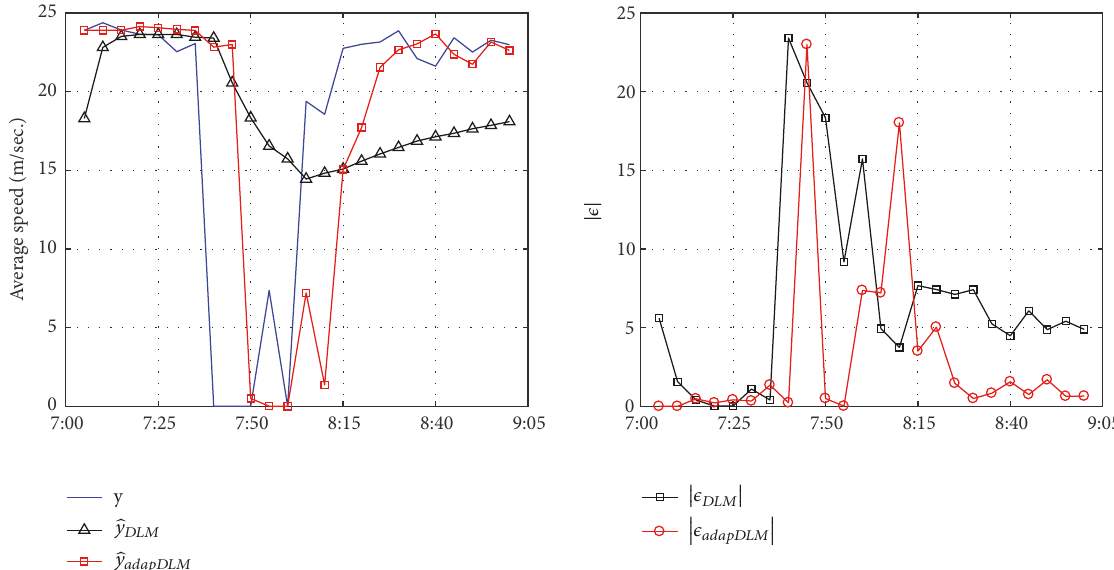
Figure 6: Comparison of one-stepforecasts andabsolute errorsfor first-orderDLMand theadaptive DLMin accidentscenarios(road section 5W). Left : the one-step forecasts of average speed. Right : absolute residuals.